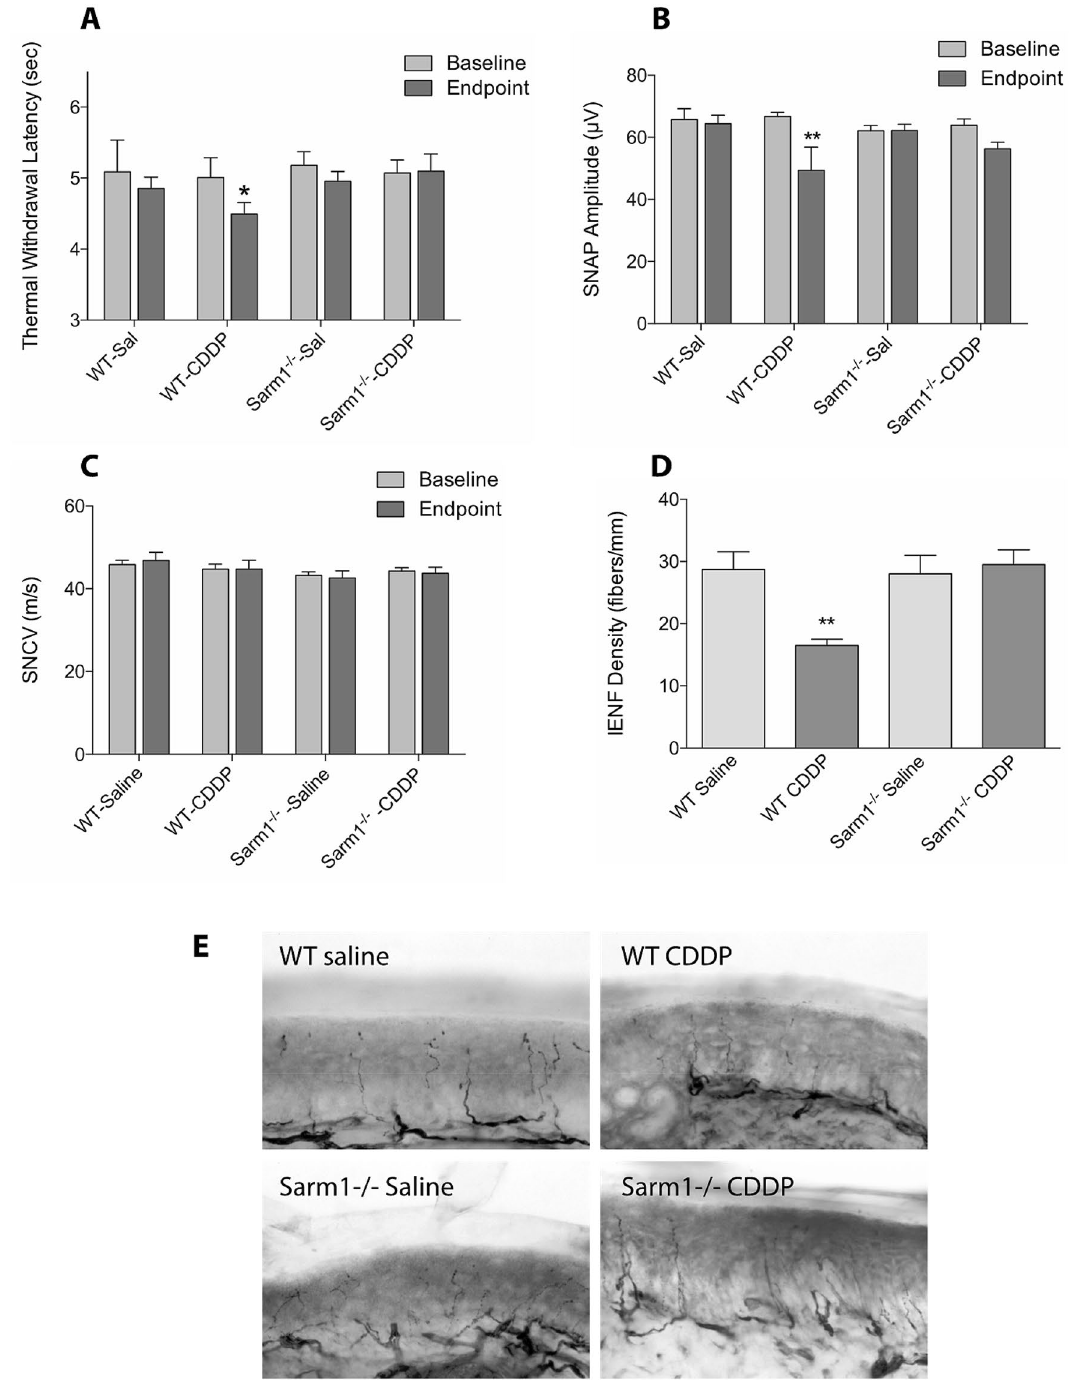
Figure 7. CDDP induced peripheral neuropathy in Sarm 1 −/− mice. Although WT mice given CDDP developed peripheral neuropathy as assessed by thermal withdrawal latency ( A ), sensory nerve action potential ( B ) and changes in epidermal innervation ( D , E ), Sarm 1 −/− mice did not develop peripheral neuropathy. There was no change in sensory nerve conduction velocity in WT or Sarm 1 −/− mice ( C ) (n = 5 per WT mice and n = 7 per Sarm 1 −/− mice, * p < 0.05, ** p < 0.005, one-way ANOVA with multiple comparisons, error bars denote